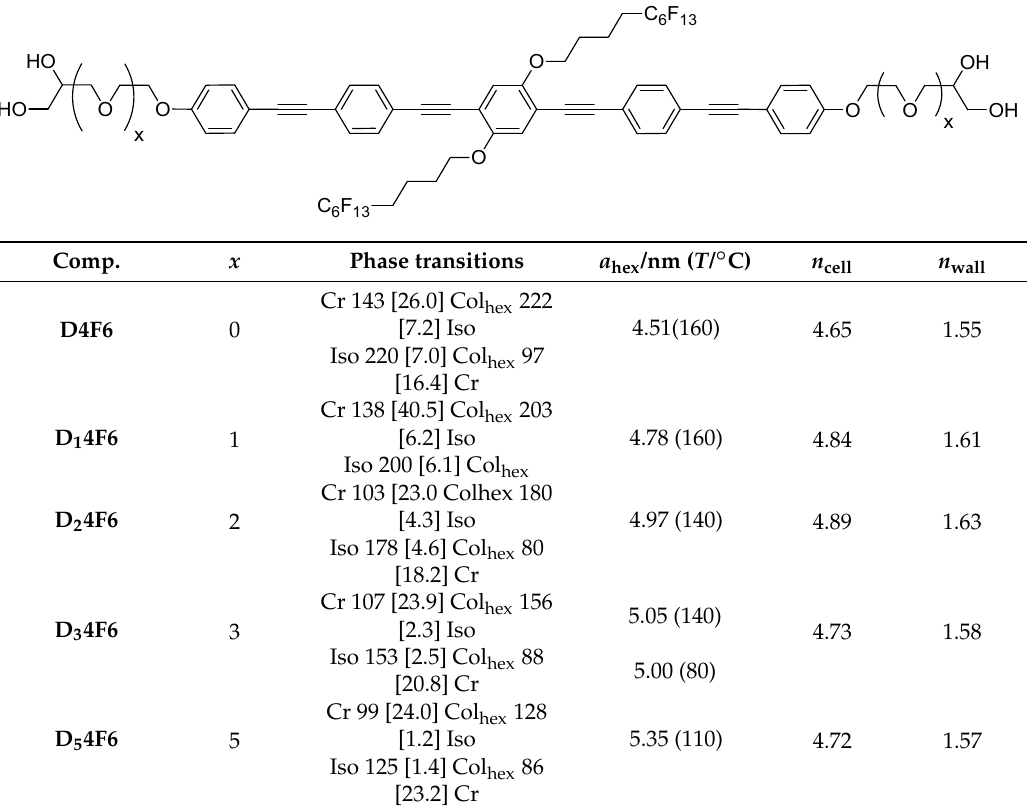
Table 4. Mesophases and phase transition temperatures ( T /°C), as observed on heating (top lines) and cooling (bottom lines), the corresponding enthalpy values ( Δ H /(kJ·mol − 1 ), in square brackets), and other parameters of compounds D x 4F6 , depending on the number of EO units x a .